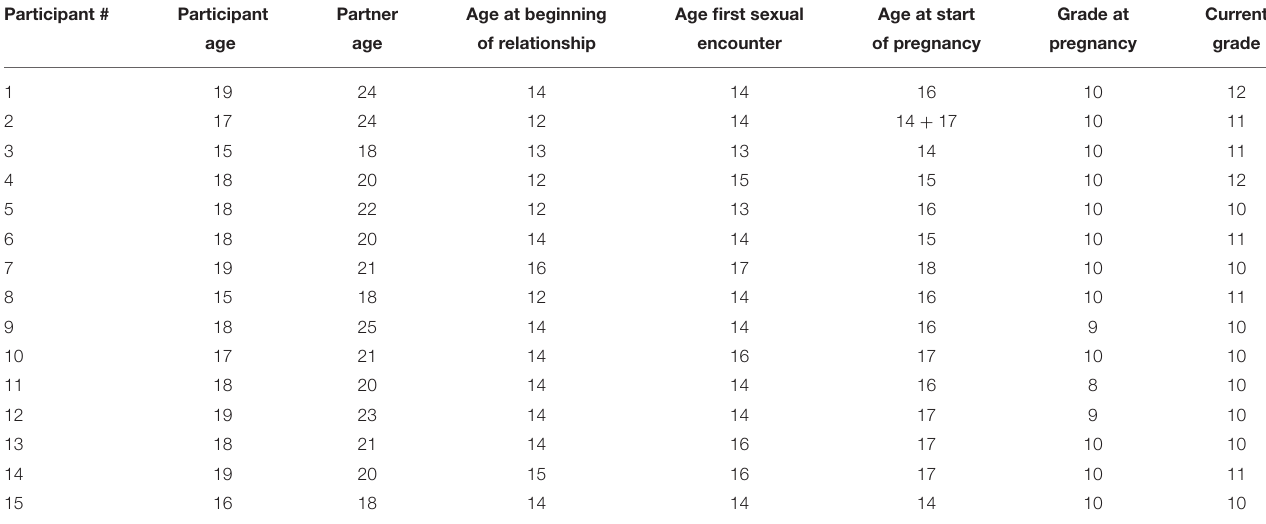
TABLE 1 | Demographic composition of narrative participants, including relationships and sexual activity. Participant